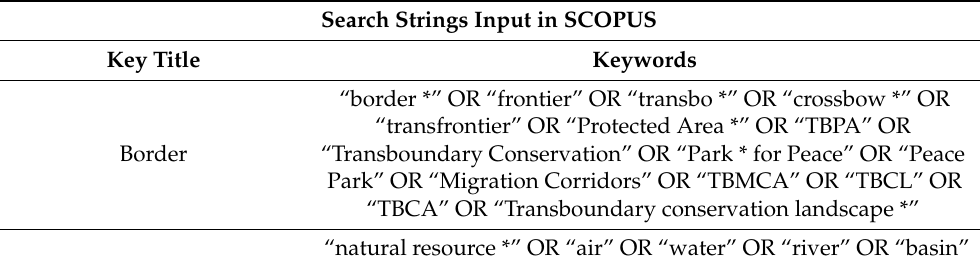
Table 1. Search strings used to retrieve articles from the